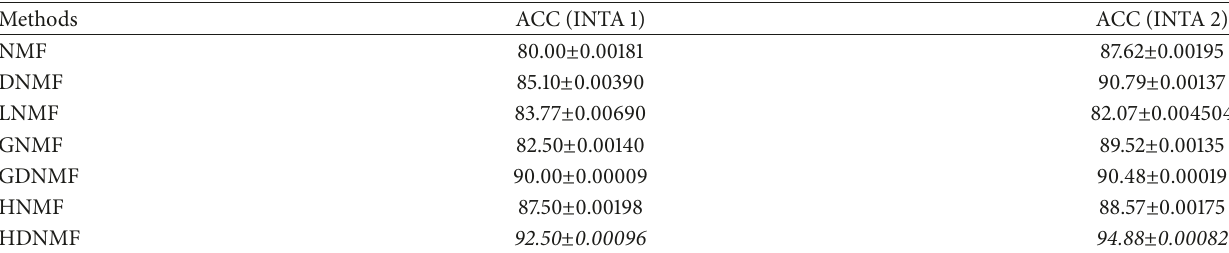
Figure 3: The convergence performance for INTA1 and INTA2. Table 3: The classification ACC for all